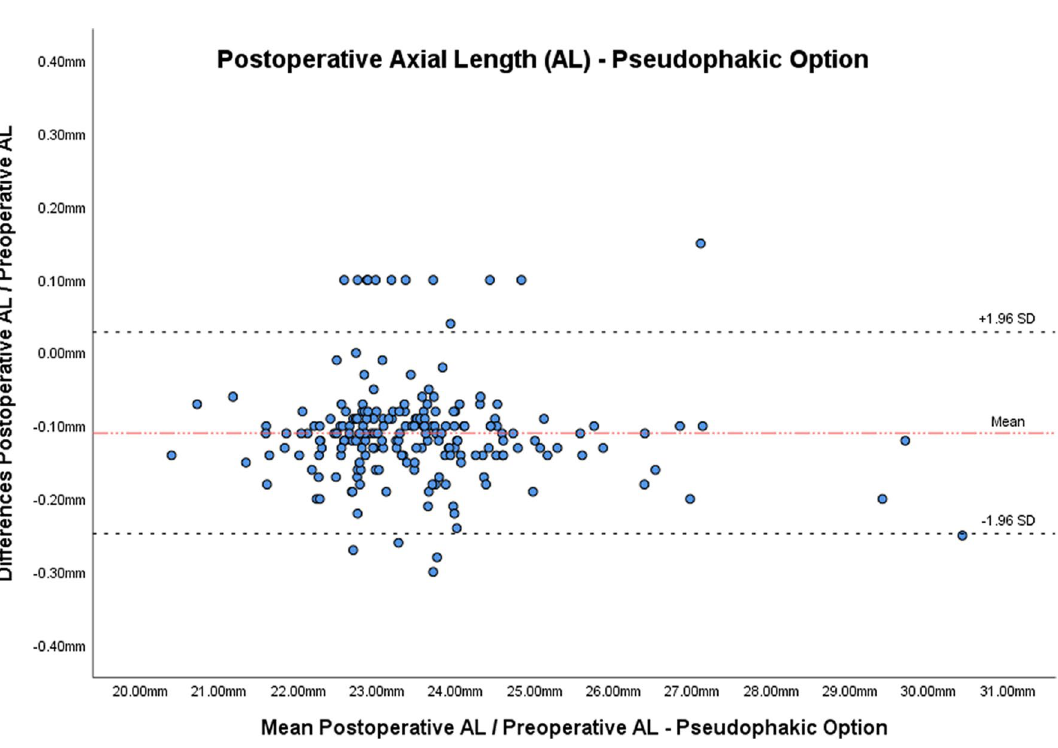
Figure 1. Bland–Altman plot of axial length measured before and after cataract surgery utilizing the pseudophakic